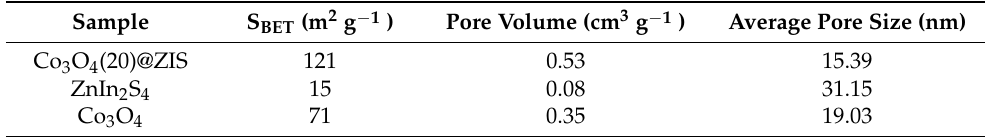
Figure 6. Nitrogen adsorption-desorption isotherms and corresponding pore size distribution curves of ( a ) Co 3 O 4 (20)@ZIS, ( b ) ZnIn 2 S 4 , and ( c ) Co 3 O 4 . of ( a ) Co 3 O 4 (20)@ZIS, ( b ) ZnIn 2 S 4 , and ( c ) Co 3 O 4 . Table 1. Adsorption parameters of Co 3 O 4 （ 20 ） @ZIS, ZnIn 2 S 4 and Co 3 O 4 . Table 1. Adsorption parameters of Co 3 O 4 (20)@ZIS, ZnIn 2 S 4 and Co 3 O 4